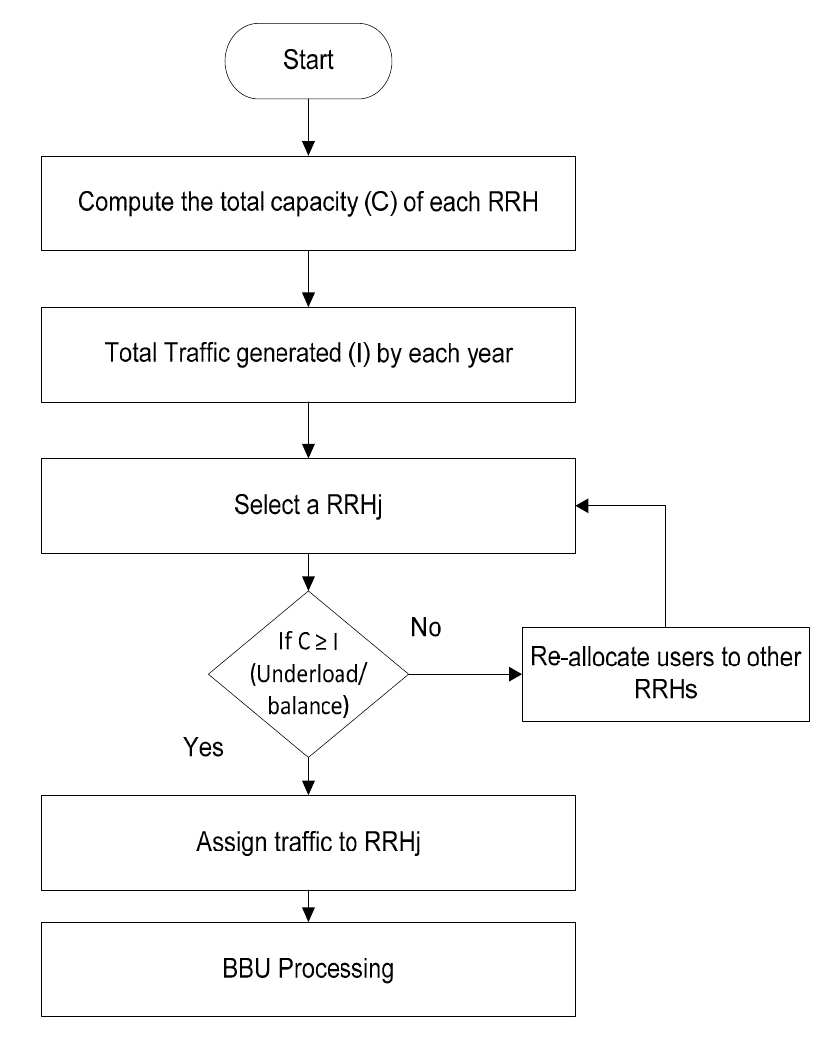
Figure 2. Load balancing in